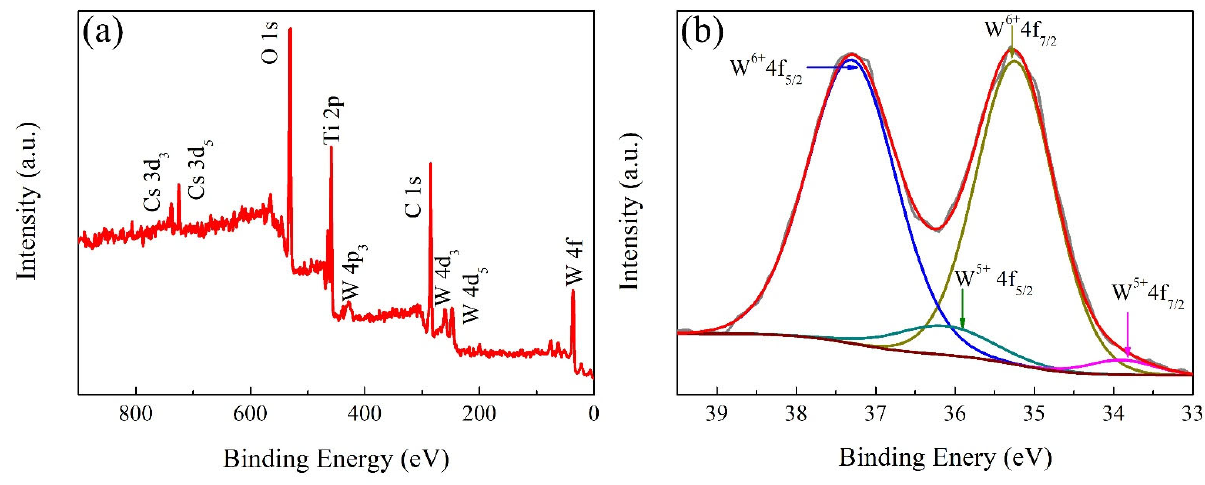
Figure 5. ( a ) Full range XPS spectra and ( b ) W 4f core ‐ level XPS spectra of CWO@0.2TiO 2 .